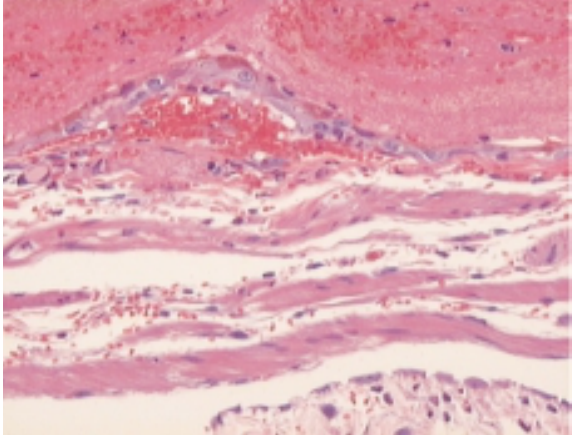
FIGURA 3 - Hemorragia intramural e polimorfonucleares caracterizando cistite hemorrágica. (HE x 100)